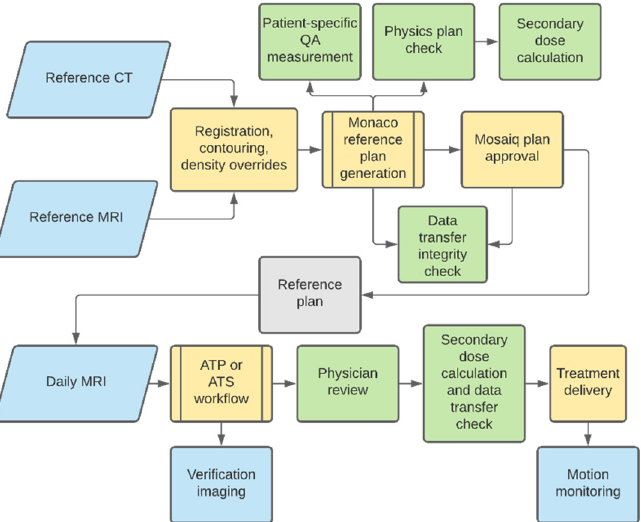
Figure 2. Workflow diagram showing major processes in treatment-plan generation and delivery. Imaging steps noted in blue, quality assurance (QA) steps noted in green, and planning or delivery steps noted in yellow.